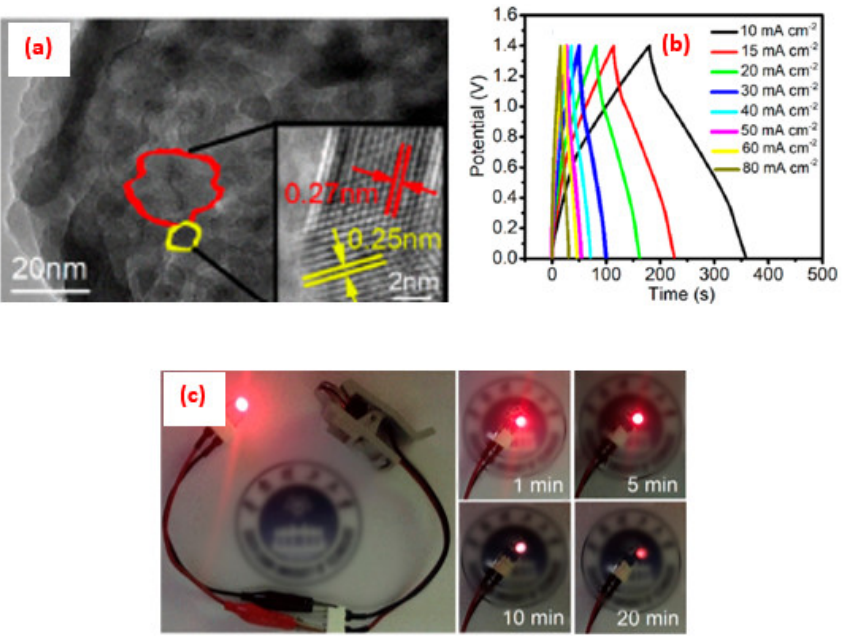
Figure 3. ( a ) TEM image of CuO/LSC73; ( b ) GCD curves; and ( c ) digital images of an LED powered by the two devices in series. Copyright 2019 by the American Chemical Society [64]. Table 1. Comparison of different perovskite-based nanocomposites for supercapacitor applications. Synthesis Materials Strategies